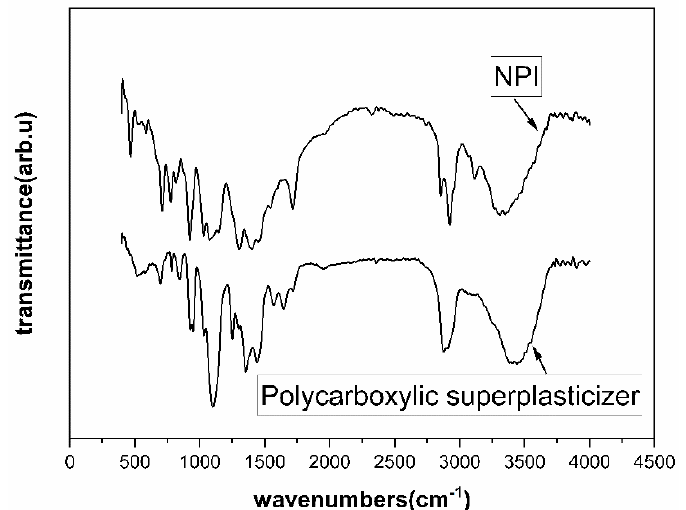
Figure 2. FT-IR spectra of polycarboxylic superplasticizer and nano-precursor inhibiting material (NPI).